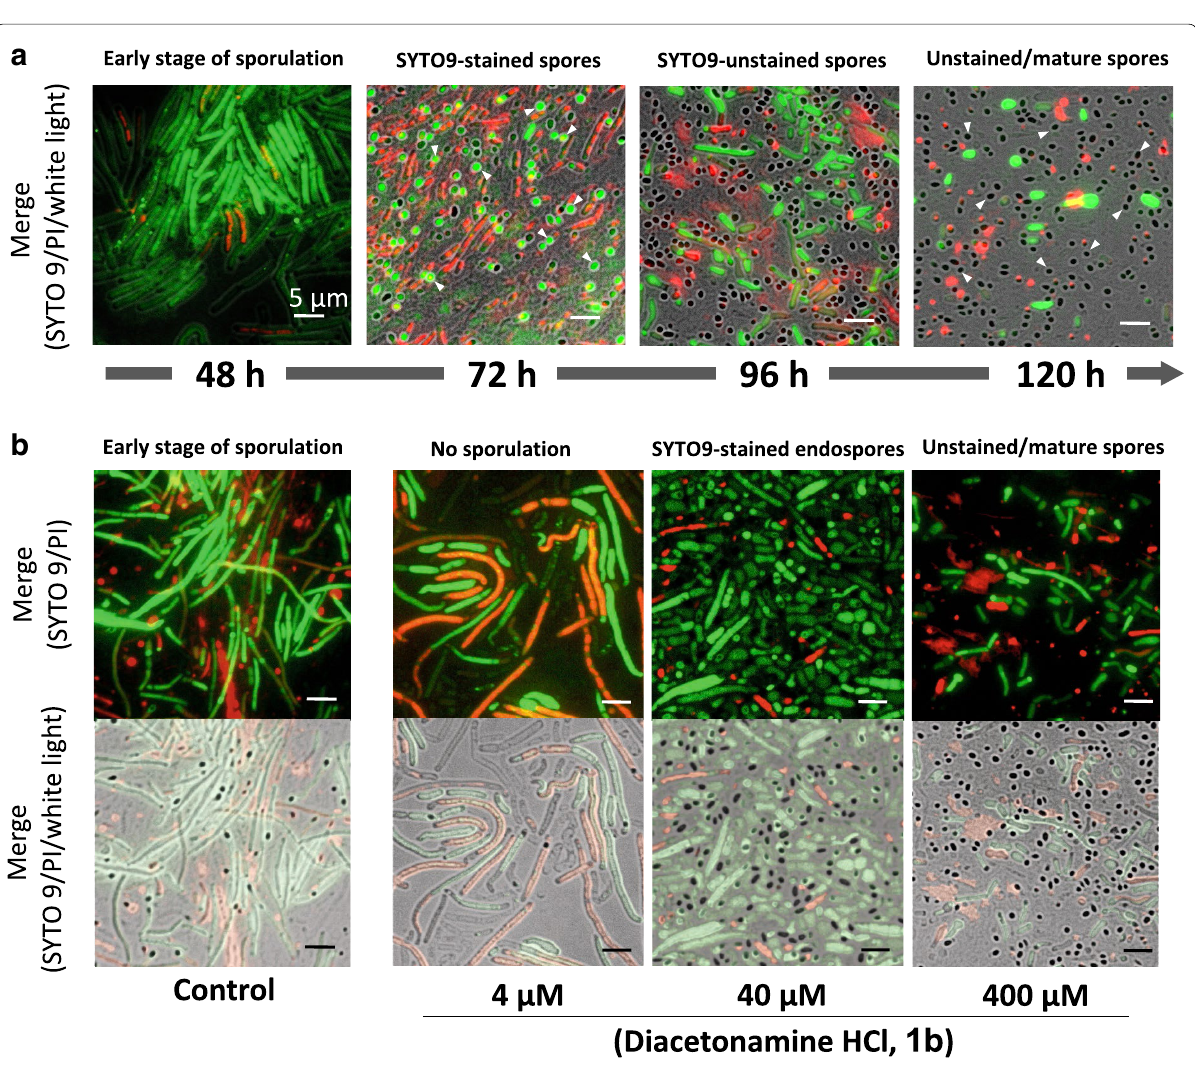
Fig. 5 Spore-inducing activity of diacetonamine hydrochloride toward B. megaterium. a Time-course (48–120 h) of sporulation in B. megaterium NBRC 15308 exposed to 400 µM of diacetonamine HCl ( 1b ). Open arrowheads in photo-images at 72 and 120 h show immature (stained with SYTO 9) and mature (unstained with SYTO 9) endospores, respectively. b Dose-dependent manner of 1b (4, 40, and 400 µM) in the sporulation of B. megaterium . At 96-h incubation, microscopic photo-images were recorded. Scale bar 5 =